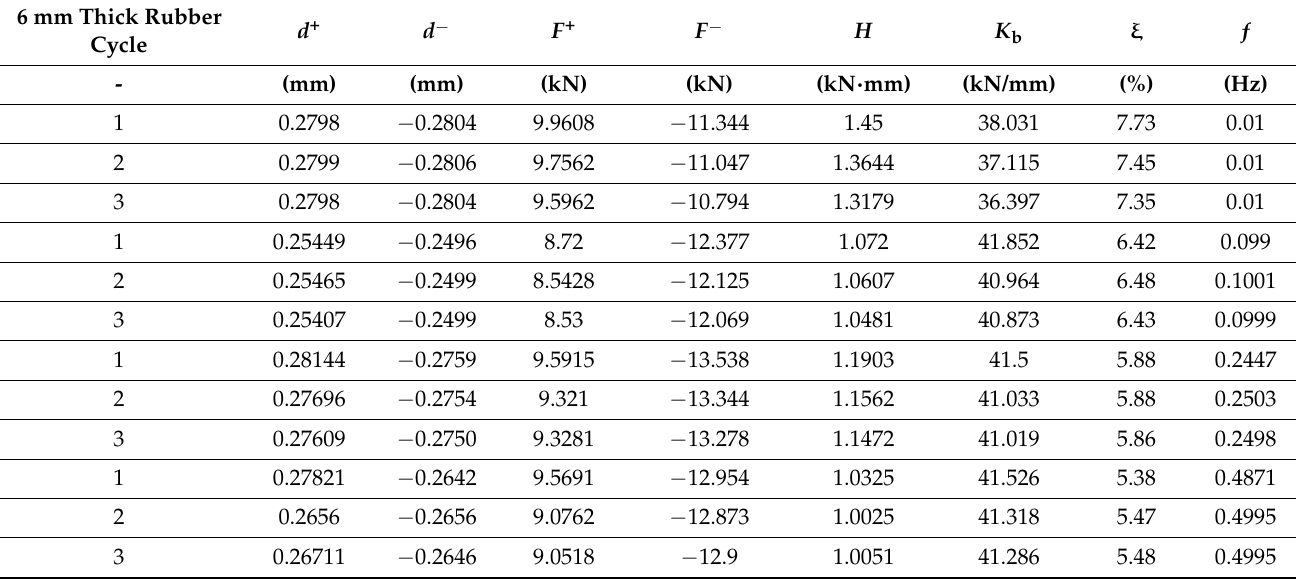
Figure 8. Plot of device testing, showing force–displacement for 6 mm thick HDR material at different frequencies. Table 4. Result data for 6 mm thick HDR material at different frequencies.